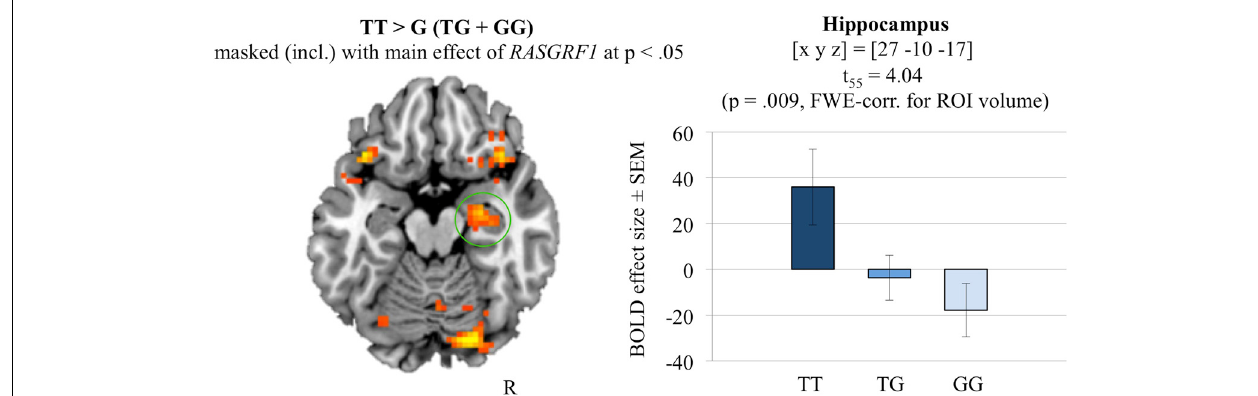
FIGURE 4 | The hippocampal recognition-encoding response for monetary reward-predicting items and its modulation by RASGRF1 genotype [constrast TT vs. G (GT + GG) masked (incl.) with the main effect of RASGRF1 at p < 0 . 05]. TT carriers showed highest hippocampal activation, when compared to G allele